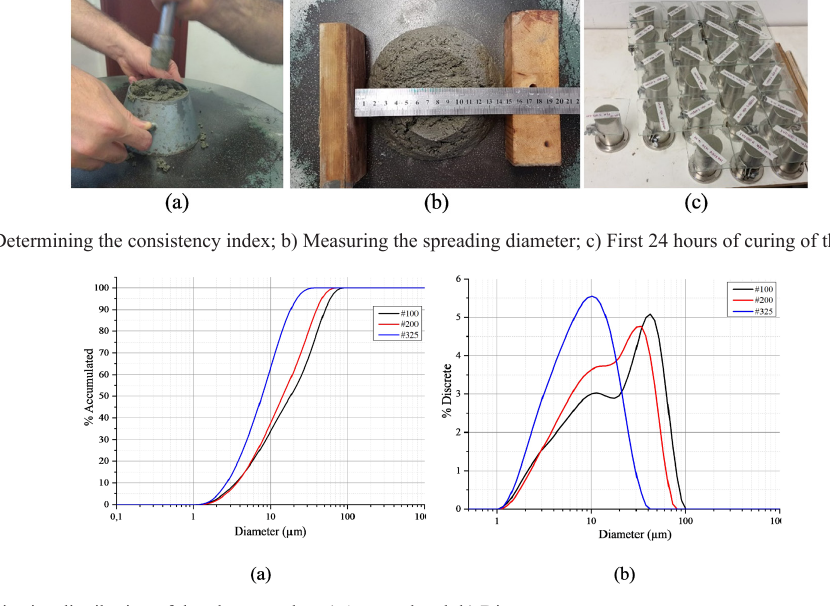
Figure 4. Grain size distribution of the glass powder: a) Accumulated; b)